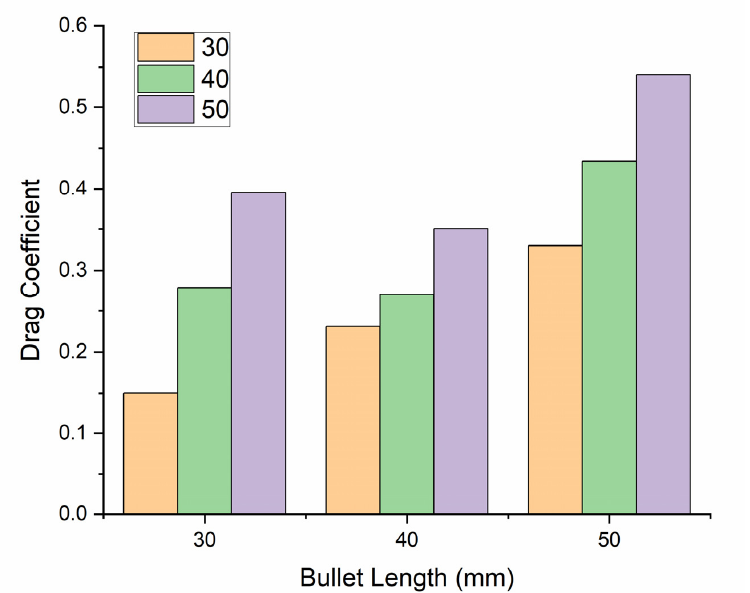
Figure 16. Simulated value of the drag coefficient of bullet head (design II) at supersonic speed at 30°,40°,and 50° angle of attack.